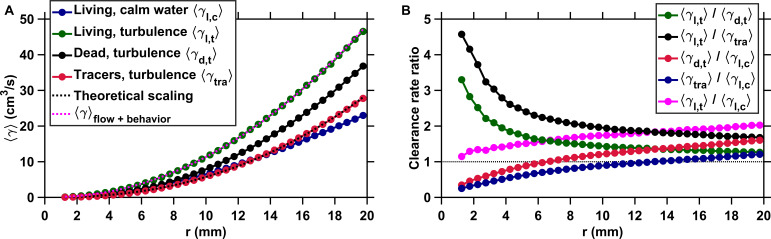
Active motion boosts encounter rates in turbulence.(A) Mean clearance rate ⟨γ⟩ versus the radius of the perception volume r for tracers (⟨γt⁢r⁢a⟩, red), dead copepods passively transported by turbulence (⟨γd,t⟩, black), and living copepods in turbulence (⟨γl,t⟩, green) and in calm water (⟨γl,c⟩, blue). ⟨γ⟩ is directly obtained from ⟨ur∣i⟩ measured for different values of the pairwise separation distance r. We verify the accuracy of our flow field measurements by plotting the theoretical prediction for the clearance rate of tracers, based on the ϵ1/3⁢r7/3 (for the inertial subrange) and r3⁢(ϵ/ν)1/2 (for the viscous subrange) Kolmogorov scaling of the velocity differences (Saffman and Turner, 1956), using proportionality constants found empirically (Pécseli et al., 2014) (dashed line, black). The prediction agrees very well with our experimental data. We show that a very accurate estimation of ⟨γl,t⟩ down to the radius of hydrodynamic interactions can be achieved by considering the separate contributions of turbulent advection and the self-locomotion of two independent organisms. We compute ⟨γ⟩f⁢l⁢o⁢w+b⁢e⁢h⁢a⁢v⁢i⁢o⁢r for living copepods in turbulence, using ur⁢(r)=ur,t⁢(r)+ur,c,b where ur,t⁢(r) is randomly drawn from the probability density function of the pairwise radial relative velocity of tracers at a given separation distance r, and ur,c,b is the pairwise radial relative velocity of the copepods. ur,c,b is computed using randomly sampled values of the organism velocity with respect to the flow ub to isolate the behavioral part of their motion. ⟨γ⟩f⁢l⁢o⁢w+b⁢e⁢h⁢a⁢v⁢i⁢o⁢r agrees very well with the measurements for r≥4 mm (dashed line, magenta). It deviates for shorter r because of behavioral interactions within the radius of hydrodynamic interactions: the ratio ⟨γ⟩f⁢l⁢o⁢w+b⁢e⁢h⁢a⁢v⁢i⁢o⁢r/⟨γl,t⟩ is approximately two at r=1 mm and one at r=4 mm. These interactions are studied in the next section. (B) Ratios of mean clearance rates. Active motion plays a preponderant role in enhancing encounter rates in turbulence, as evidenced by a ratio ⟨γl,t⟩/⟨γd,t⟩ (green) larger than one, especially at short r comparable to or below the radius of hydrodynamic interactions. ⟨γl,t⟩ results from turbulent velocity differences, organism motion, and inertia, while ⟨γd,t⟩ results from turbulent velocity differences and inertia only. The contribution of inertia to γ is lower than that of self-locomotion but not negligible: the ratio ⟨γl,t⟩/⟨γt⁢r⁢a⟩ (black), where ⟨γt⁢r⁢a⟩ is the mean clearance rate of small, neutrally buoyant flow tracers that have negligible inertia, is larger than ⟨γl,t⟩/⟨γd,t⟩. This indicates that the combination of turbulent velocity differences and effects due to inertia leads to a larger γ than turbulent velocity differences alone. We also note that while being passively transported by turbulence leads to a larger γ at large r compared to motility in still water, as evidenced by the ratios ⟨γd,t⟩/⟨γl,c⟩ (red) and ⟨γt⁢r⁢a⟩/⟨γl,c⟩ (blue) above one for large r, it provides less mating opportunities than self-locomotion in calm hydrodynamic conditions at shorter r. This indicates that being passively transported by the flow is not an efficient mechanism to encounter many mates within the perception radius. It requires active swimming in turbulence for copepods to achieve an encounter rate that is comparable or even larger than in calm hydrodynamic conditions (ratio ⟨γl,t⟩/⟨γl,c⟩, magenta).Figure 2—source data 1.Source data for Figure 2.